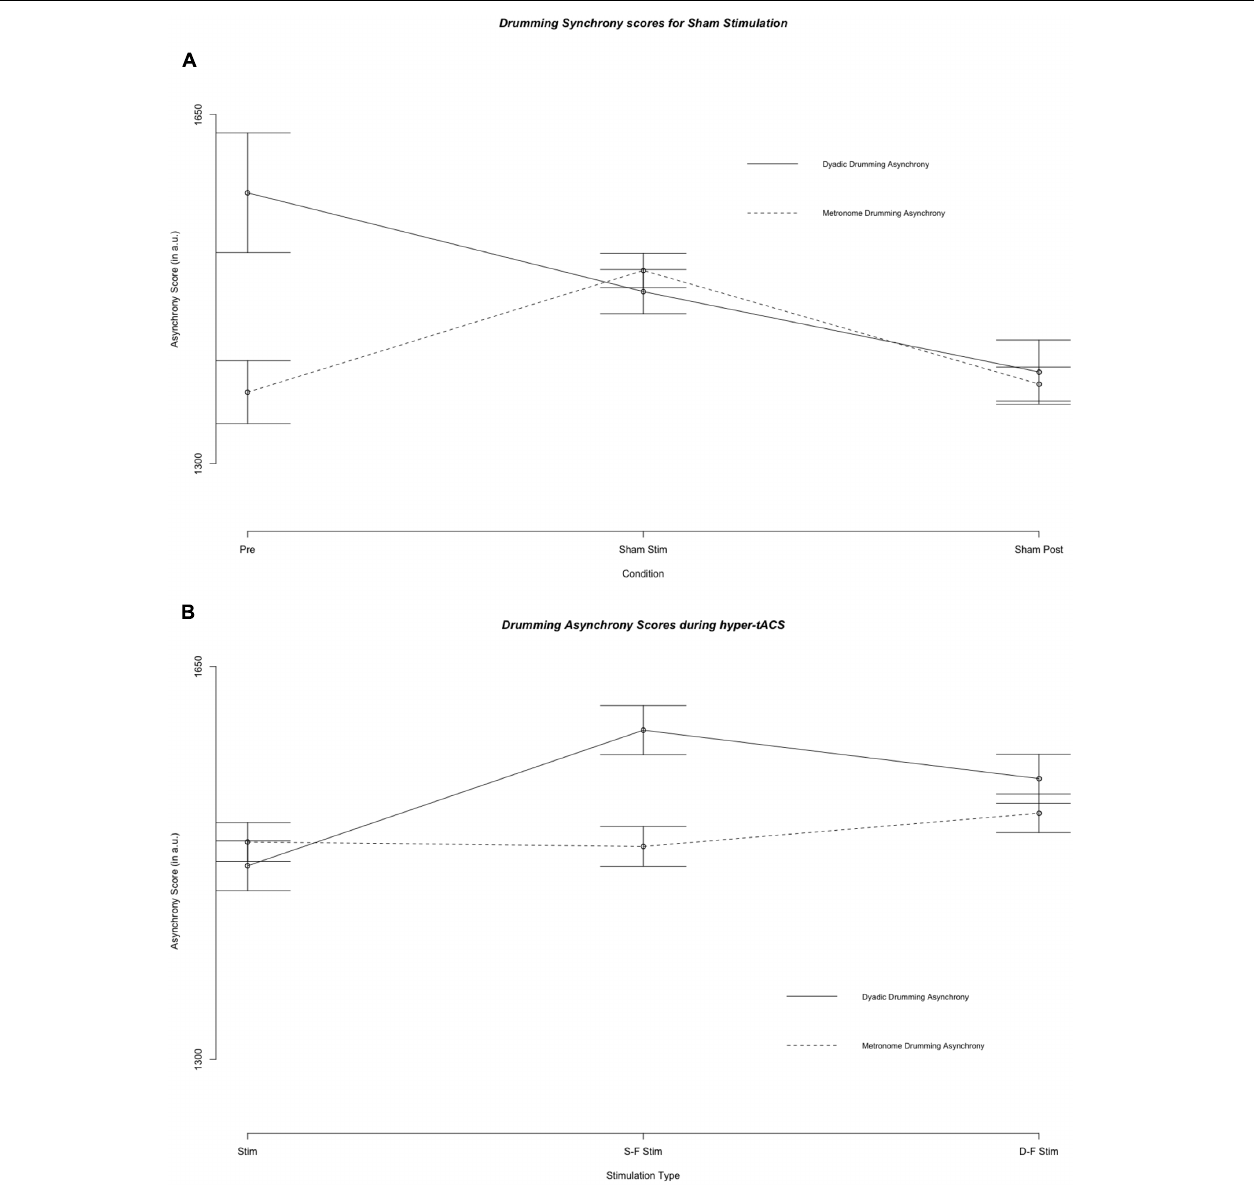
Figure 5 for a comparison of individual and dyad preferred tempo by condition. Linear regression analysis with the sum of both players’ mean individual preferred tempo and the fastest mean individual preferred tempo as factors showed a predictive effect of the sum on variance in mean dyad preferred tempo [ F (40) = 10.77, p < 0.0005, R 2 adjusted = 0.317; sum: t (40) = 2.056, p < 0.05)]. Linear mixed model analysis showed differential effects for conditions (combination of stimulation type and experimental segment) on dyad preferred tempo